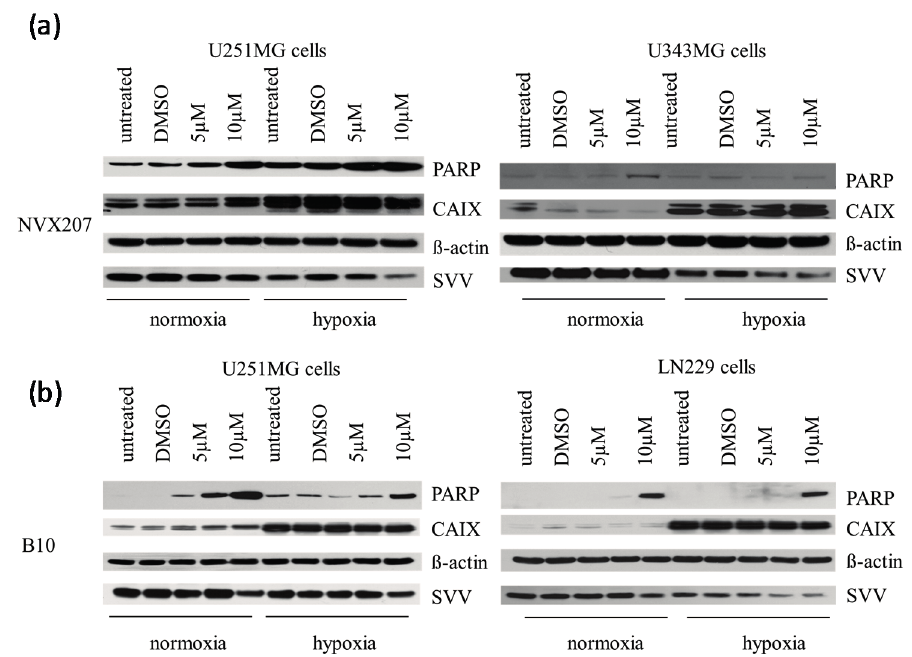
Figure 4. Effects of NVX-207 and B10 on protein expressions of PARP, CAIX and Survivin in glioma cells using Western blot analysis. NVX-207 and B10 treatment affects cleavage of PARP and expression of Survivin in glioma cells. However, there was no change in the expression levels of hypoxia-induced CAIX. β -Actin served as an internal loading control. Cell lines were untreated or treated using DMSO or increasing doses of NVX-207 ( a ) or B10 ( b ) under normoxic or hypoxic conditions. The Western blot analysis showed one representative result of three independent experiments.